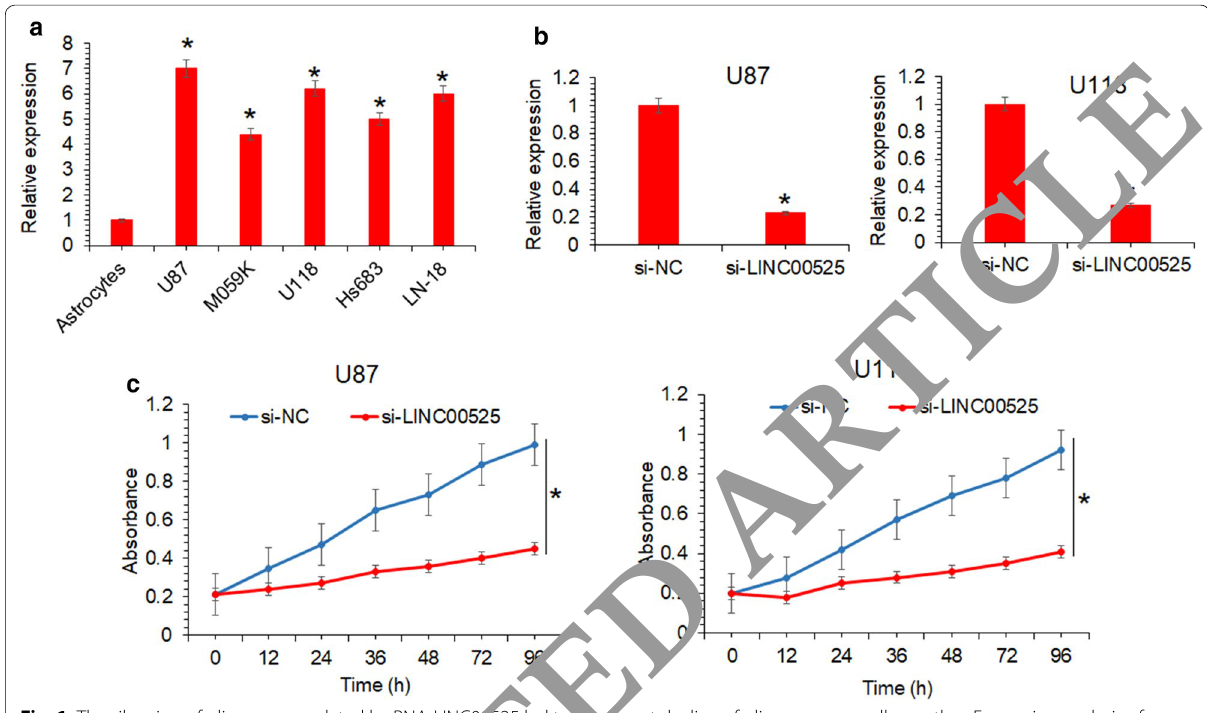
Fig. 1 The silencing of glioma upregulated lncRNA-LINC00525 led to significant decline of glioma cancer cell growth. a Expression analysis of lncRNA-LINC00525 from glioma cancer cell lines (U87, MO59K, U118, Hs683 and LN-18) in comparison to normal astrocytes, b RT-PCR expression study of lncRNA-LINC00525 in U87 and U118 cancer cells transfected with si-NC or si-LINC00525, c the estimation of proliferation of U87 and U118 cancer cells transfected with si-NC or si-LINC00525 by MTT assay. The experiments were performed in triplicate and expressed as mean (*P <